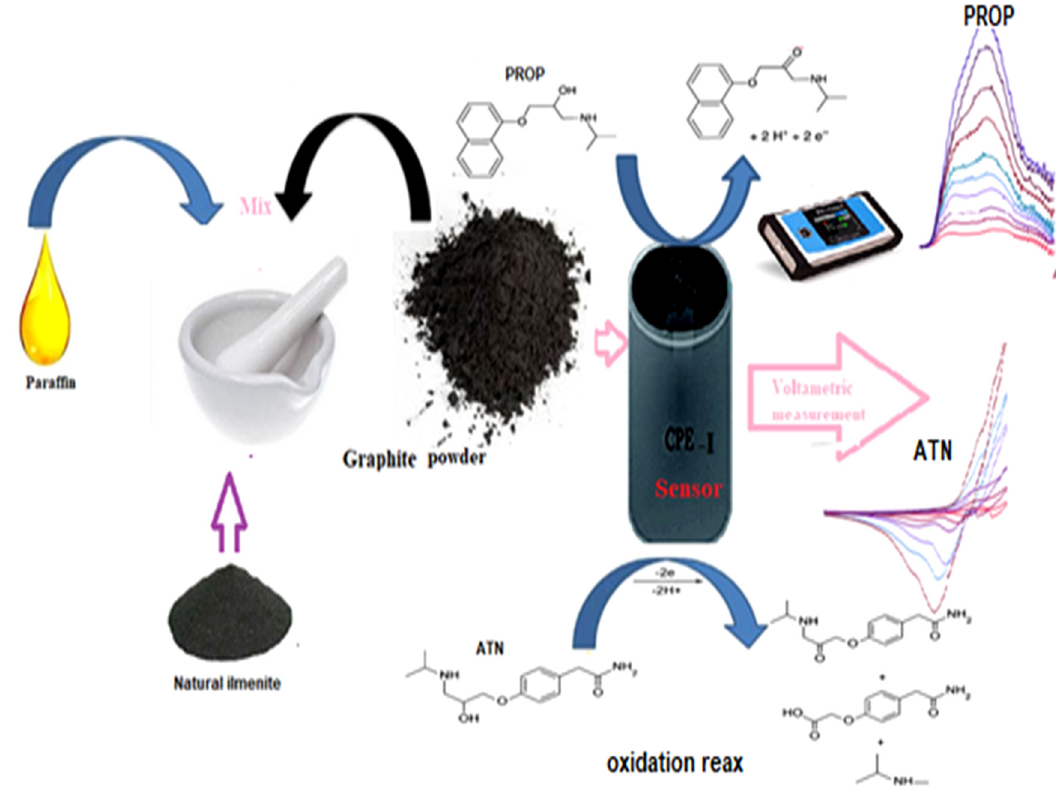
Figure 1: Schematic of experimental mechanisms of electrooxidation of ATN and PROP at surface of CPE - I